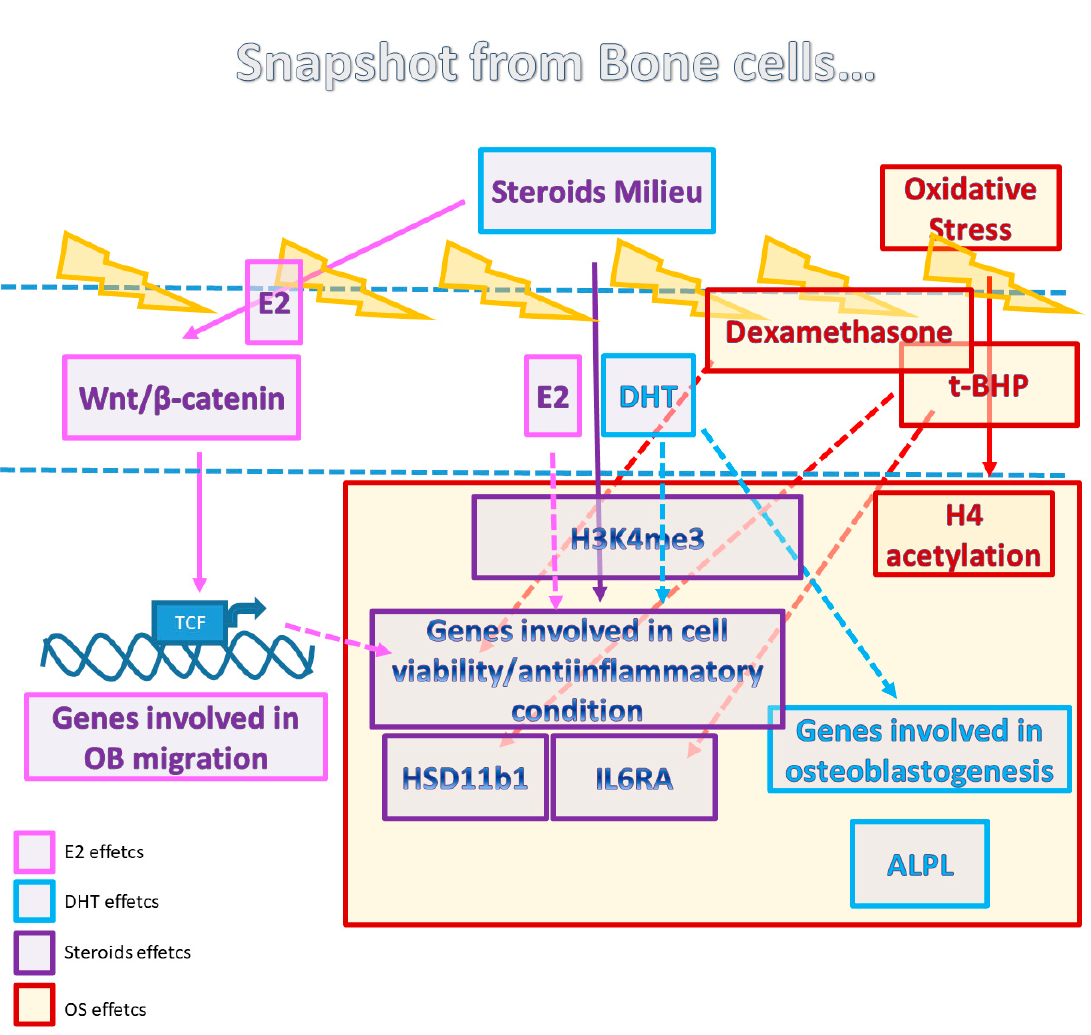
Scheme 1. A snapshot from bone cells. The scheme shows a possible strategy used by steroids in counteracting oxidative stress. The violet box (and arrows) indicates the effects of both DHT and E2. The pink box (and arrows) shows the E2 effects. The blue box (and arrows) indicates the DHT effects. The red box (and arrows) shows the effects of oxidative stress.